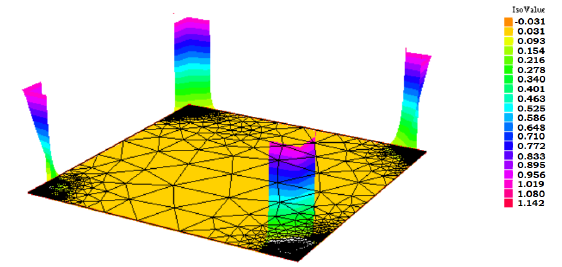
Figure 2. Computed solution for example 1, displayed on the mesh adapted with η Z and c = 0.3.